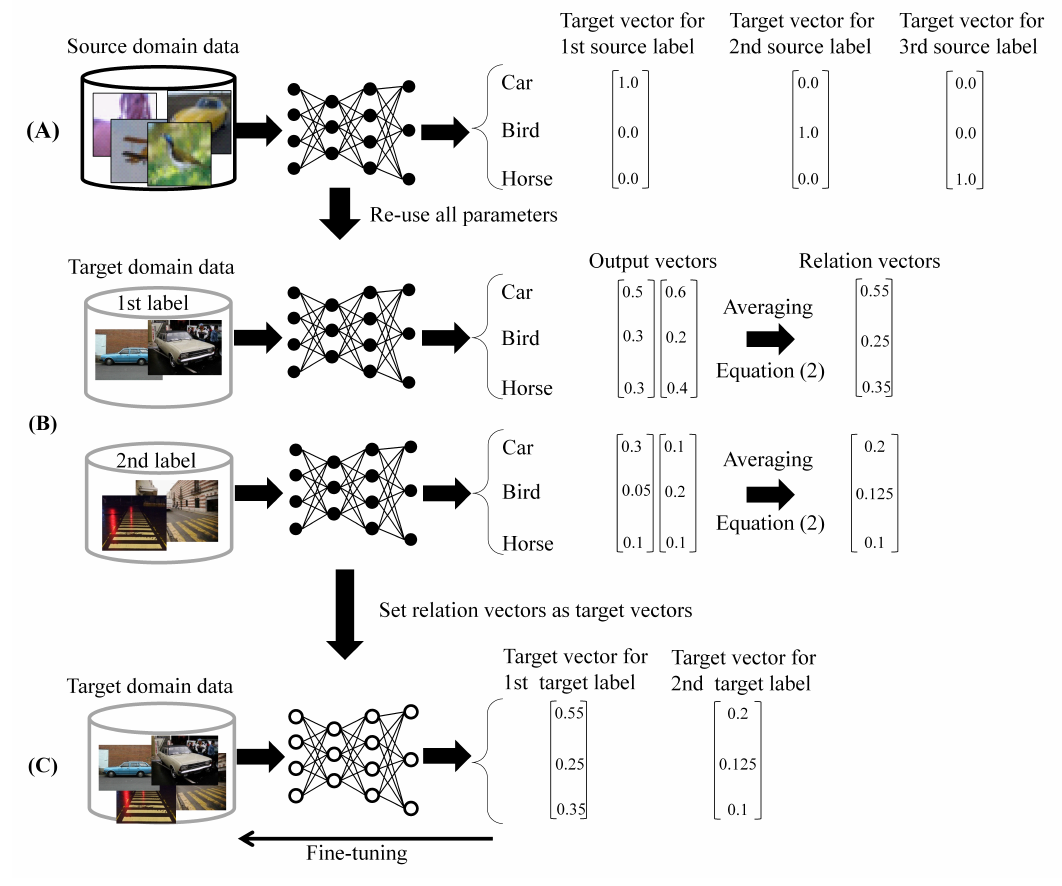
Figure 1. Outline of ATDL. ( A ) Training the first DNN using the labeled source domain data, ( B ) estimating relation vectors of each target domain label by averaging, and ( C ) optimizing all parameters to classify the target domain data using estimated relation